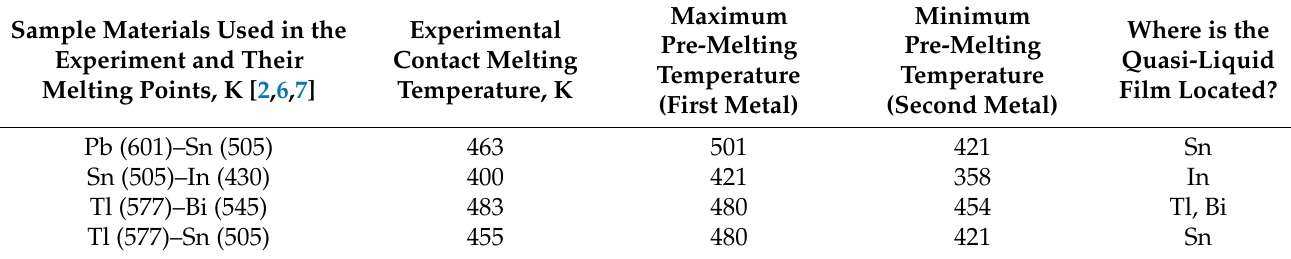
Table 1. Experimental contact melting temperature and quasi-liquid layer temperature for some metals. Sample Materials Used in the Experiment and Their Melting Points, K